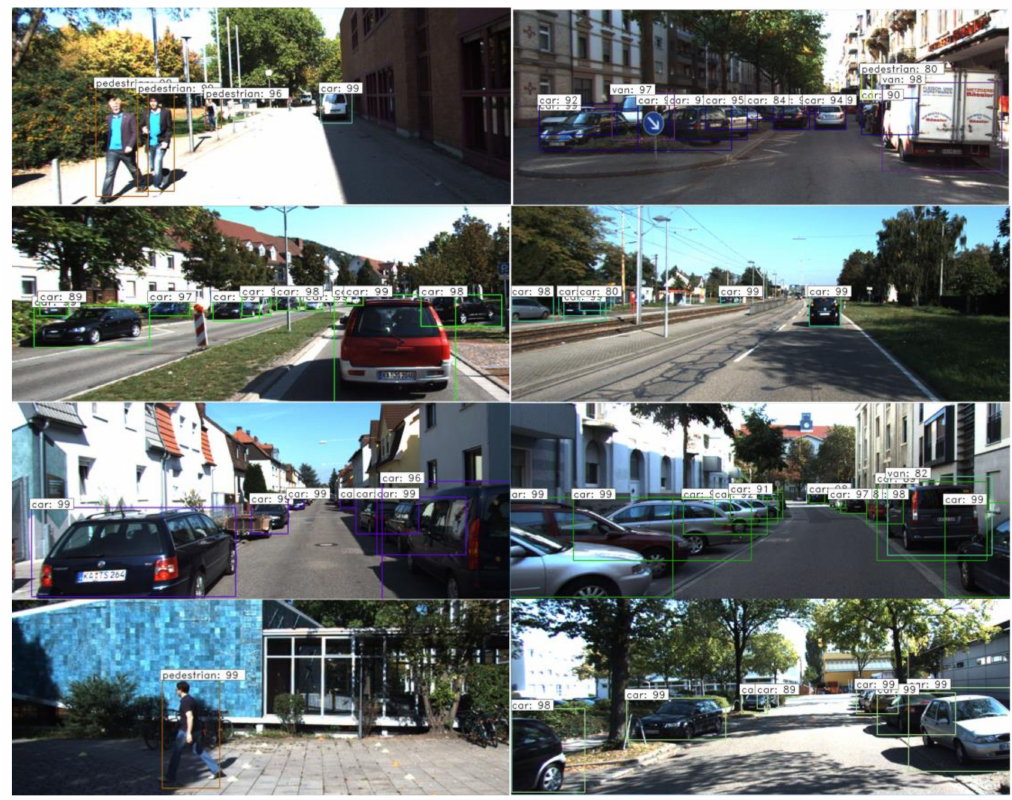
Figure 6. The picture shows the result that using the trained network to detect the test data set of KITTI.